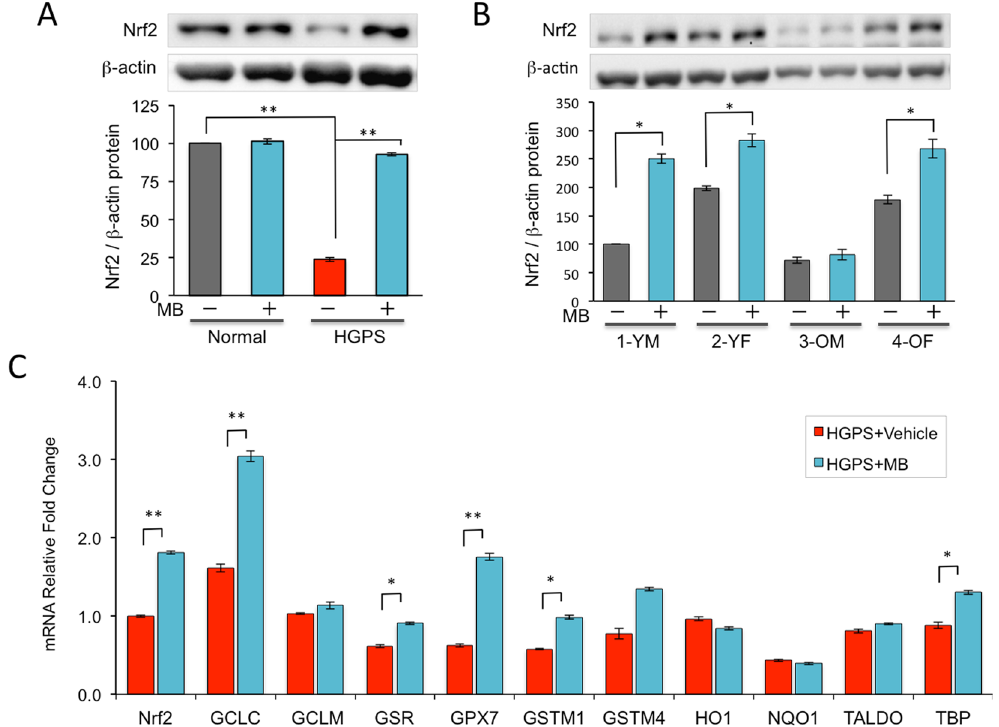
Figure 3. MB upregulates the expression of Nrf2 and its downstream ARE-response genes in human fibroblasts. ( A ) Western blotting analysis showing the changes of Nrf2 protein amounts in normal and HGPS fibroblasts upon four weeks of MB treatment at 100 nM. ( ** p < 0.01) ( B ) Western blotting analysis showing the changes of Nrf2 protein amounts in the two young and two old fibroblasts after four weeks of treatment upon four weeks of MB treatment at 100 nM. ( * p < 0.05) ( C ) Quantitative RT-PCR analysis showing mRNA levels of Nrf2 and its targeting ARE genes in HGPS fibroblasts after four weeks of MB treatment at 100 nM. ( * p < 0.05; ** p <